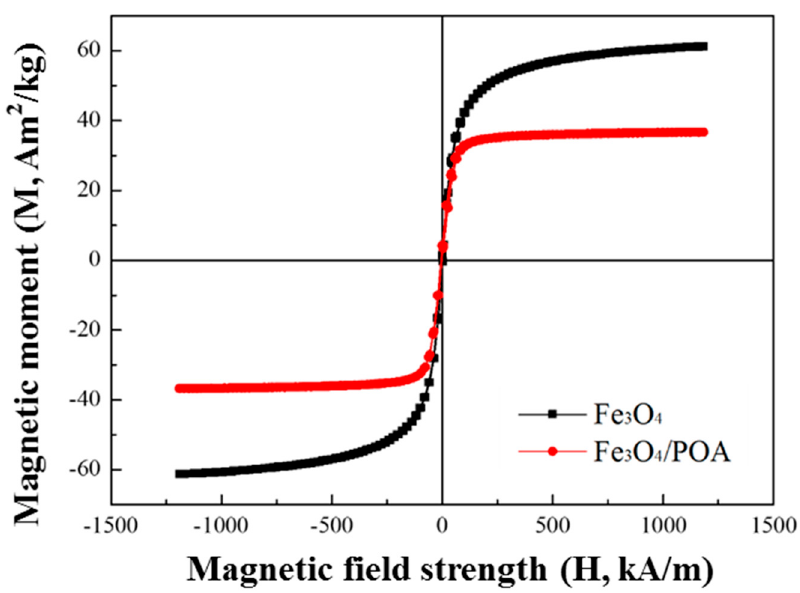
Polymers 2018 , 10 , x FOR PEER REVIEW Figure 5. VSM curves of pure Fe 3 O 4 particles and Fe 3 O 4 /POA core-shell microspheres.